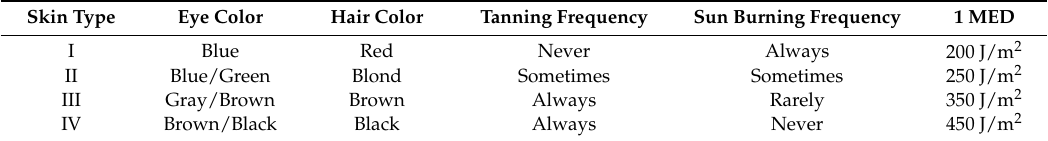
Table 1. The basic skin types for the European population [10]. MED, minimal erythemal dose.